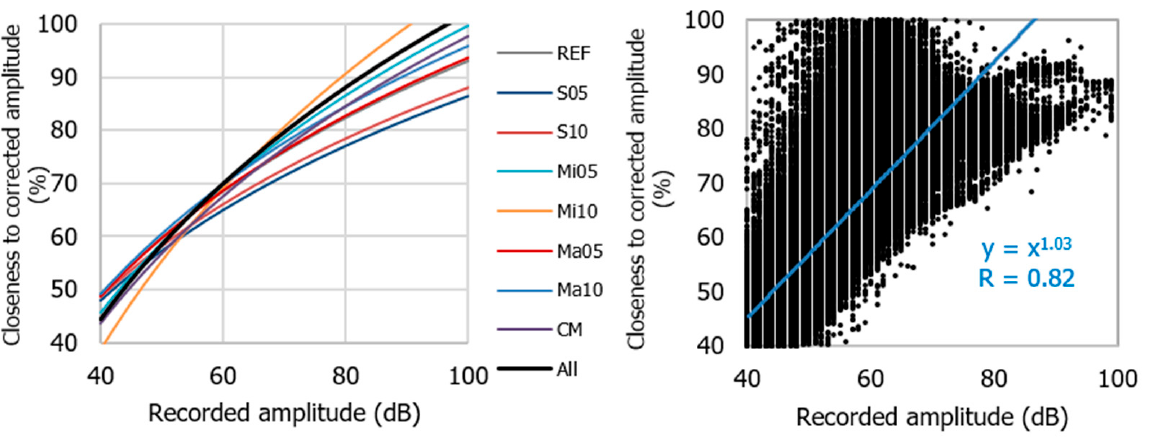
Figure 10. Recorded amplitude vs. closeness to corrected amplitude relations.